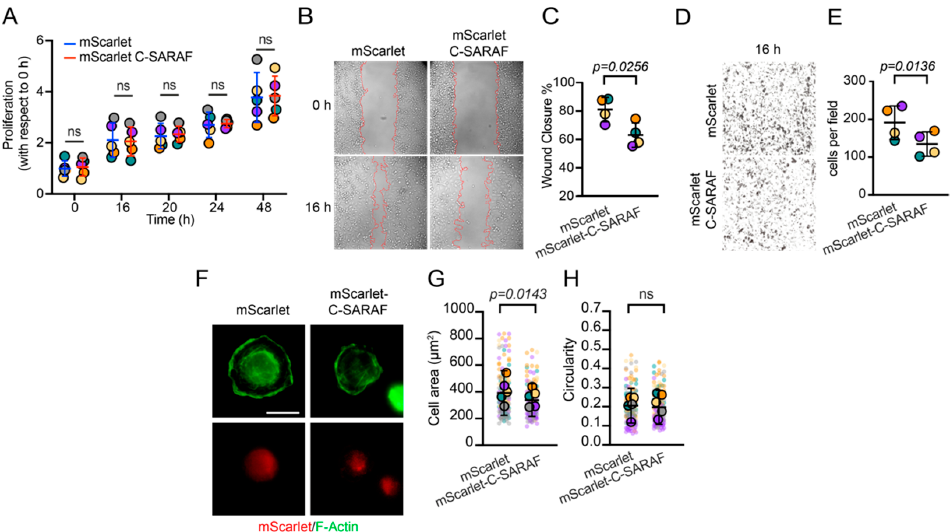
Figure 3. The C-terminal fragment of SARAF reduces malignant features in TNBC. ( A ) MTT proliferation assay of MDA-MB-231 cells overexpressing mScarlet or mScarlet-C-SARAF (N = 5). Statistical analyses correspond to Mann–Whitney’s non-parametric t -test. Bars represent the average of individual points. Error bars correspond to standard deviation. ( B ) Representative images of migration assay in MDA-MB-231 overexpressing mScarlet or mScarlet-C-SARAF. ( C ) Quantification of the gap closure (N = 4) observed in ( B ). Bars represent the average of individual points. Error bars correspond to standard deviation. Statistical analysis corresponds to Mann–Whitney’s non-parametric t -test. ( D ) Representative images of Transwell ® cell invasion assay on cells overexpressing mScarlet or mScarlet-C-SARAF in MDA-MB-231 cells. ( E ) Quantification of invading cells in ( D ). Bars represent the average of individual points. Error bars correspond to standard deviation (N = 4). Statistical analysis corresponds to Mann–Whitney’s non-parametric t -test, which was applied to define statistical significance. ( F ) Representative panels of the effect of mScarlet or mScarlet-C-SARAF overexpression on the cell spreading of MDA-MB-231 cells (N = 5). ( G ) Graph of total cell area of MDA-MB-231 cells. ( H ) Graph indicating circularity of MDA-MB-231 cells. Mann–Whitney’s non-parametric t-test was applied to define statistical significance. Bars represent average response. Individual points represent the response of each cell. Colored circles represent the average of each independent experiment. Scale bar = 20 µm.